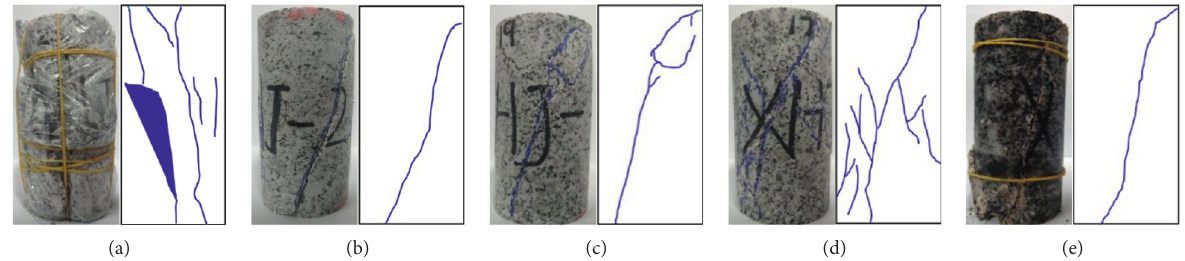
Figure 8: Failure characteristics of specimens under various confining